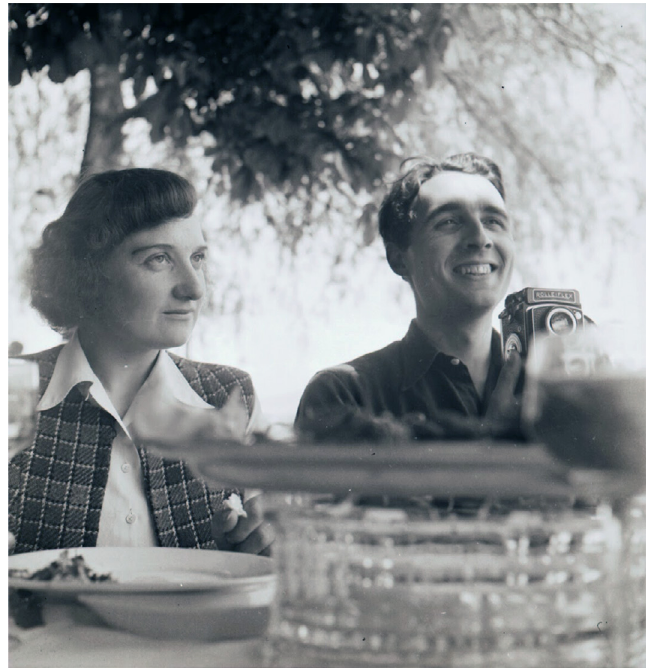
Fig. 1 Warja Lavater with